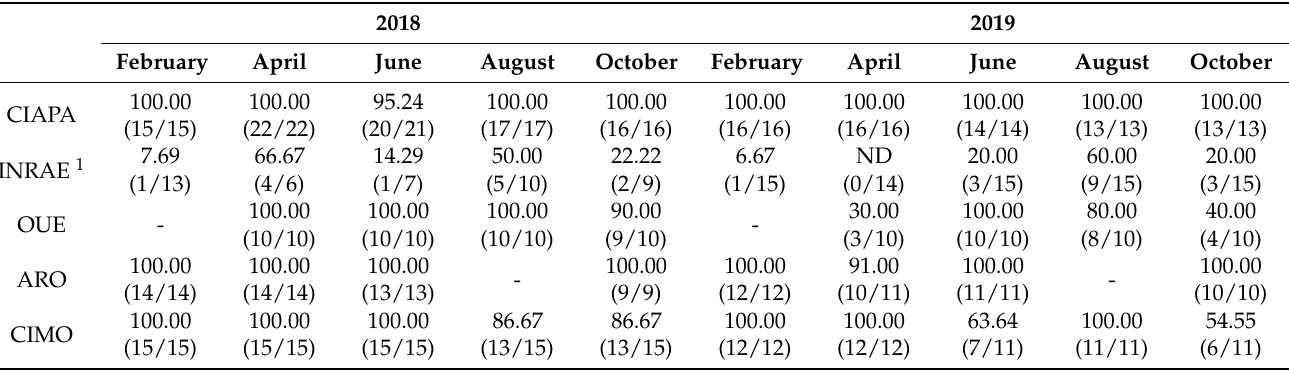
Table 2. Percentage of colonies positive for N. ceranae per sampling and apiary and number of positive colonies out of sampled colonies in parenthesis. SMI had 10 colonies where Nosema spp. were never detected. ND: Not detected.